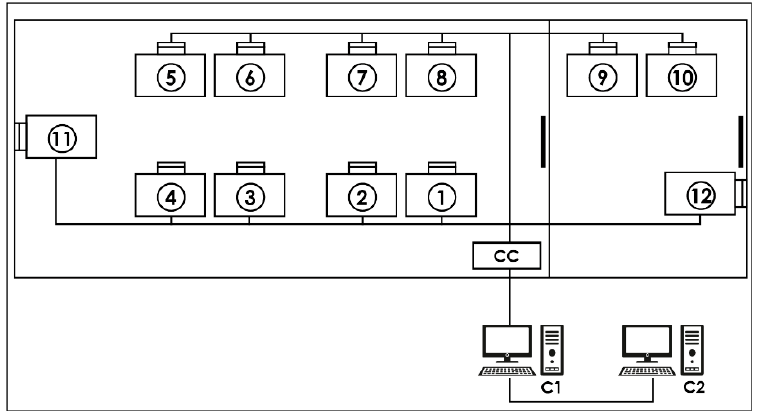
Figure 1. Data acquisition system: Each number represents a place for a crew member equipped with a pulse oximeter. CC—concentrator box that receives the serial data from each location via cables. C1—“MasterBio” computer allowing the storage and display of serial data in real time. C2—“ Analysis ” computer that backs up the serial data.